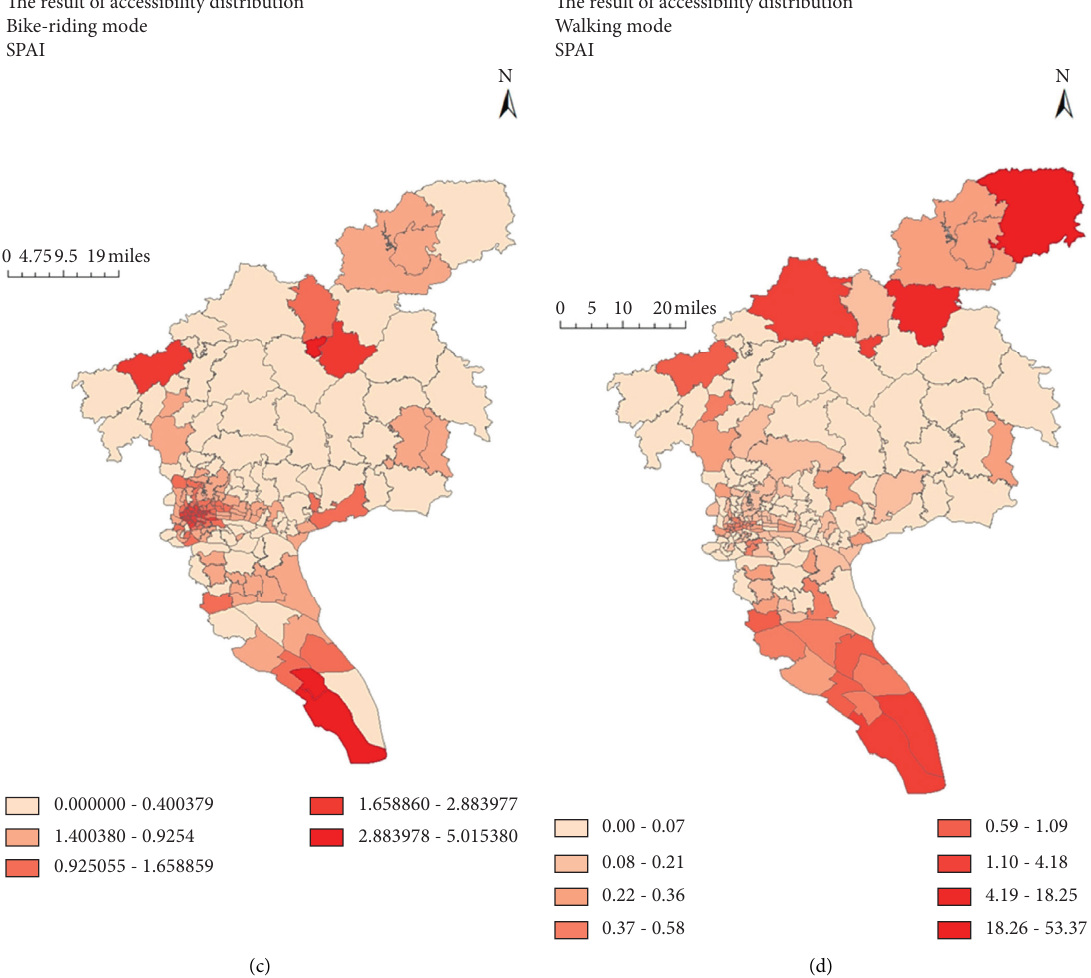
Figure 4: The distribution of SPAR of medical facilities in different traffic